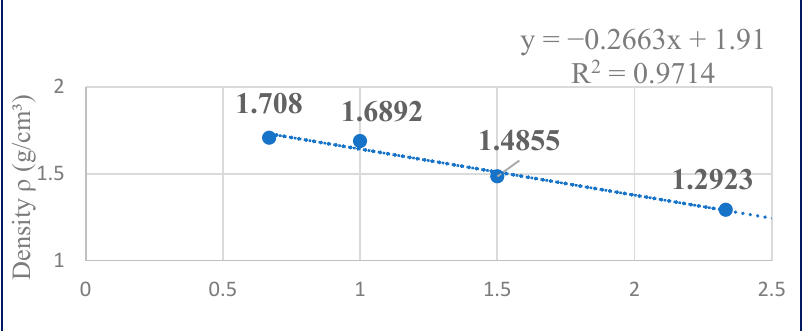
Figure 4. Density versus mud drilling slag ratio curve.